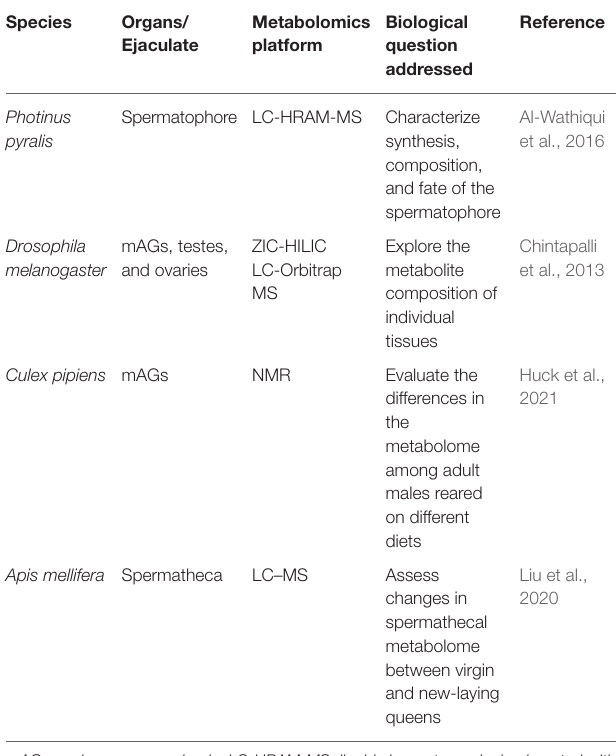
TABLE 1 | Metabolomics studies performed on insect reproductive tissues and